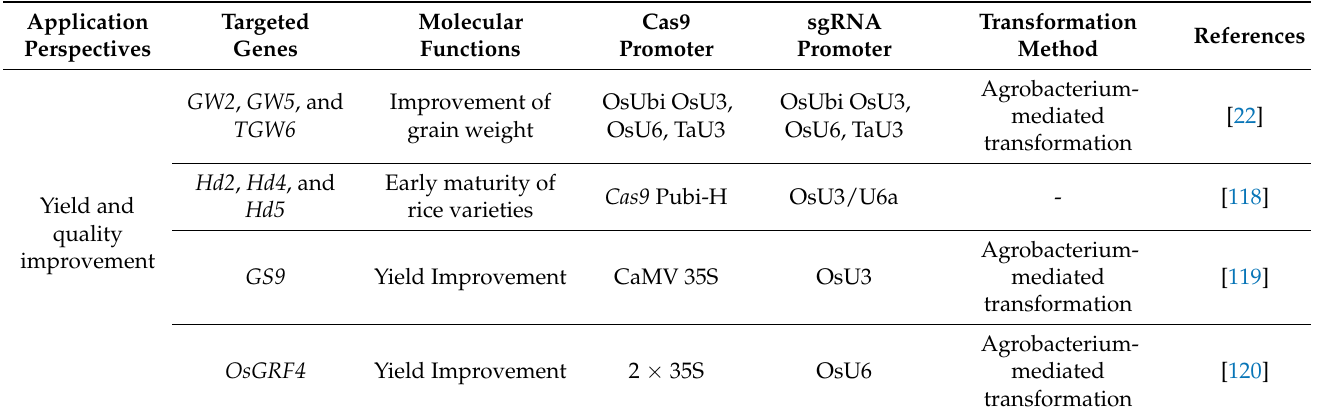
Table 4. A list of genes involved in a variety of agriculturally relevant parameters targeted by